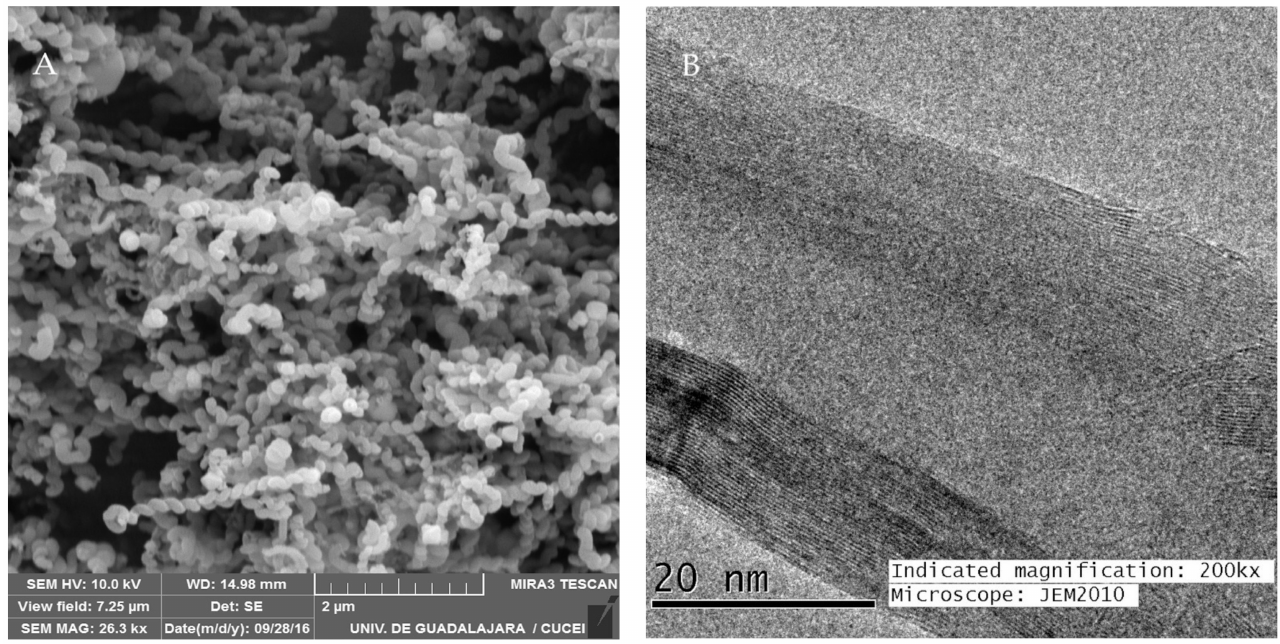
Figure 1. Micrograph of the CNTs p obtained by FE-SEM ( A ) and micrograph of the CNTs p obtained by HR-TEM ( B